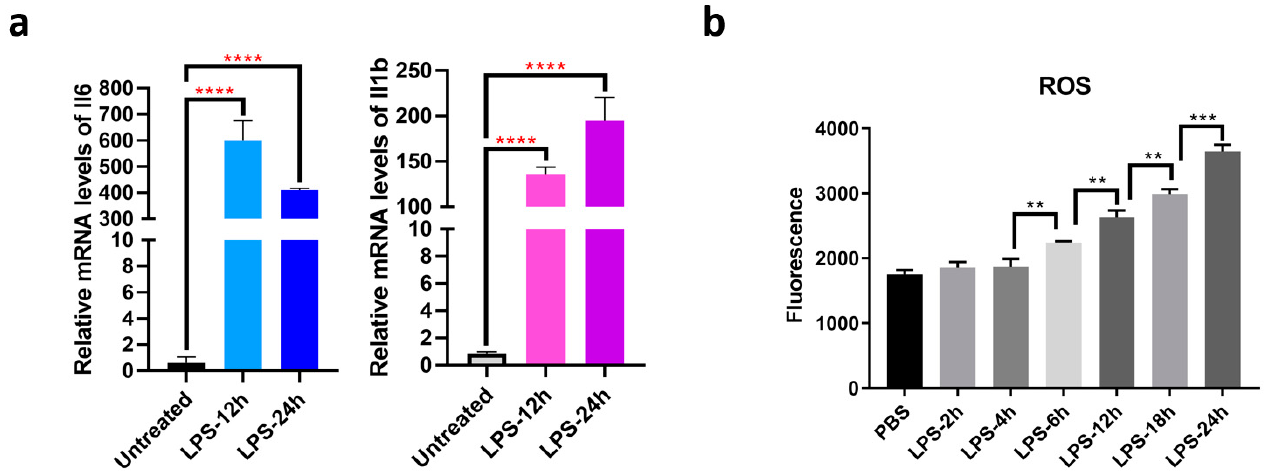
Figure 2. The production of ROS during macrophage activation. ( a ) Il-6 and Il-1 β mRNA levels in RAW264.7 cells treated with LPS; ( b ) Detection of cellular ROS during macrophage activation. **: p < 0.01. ***: p < 0.001. ****: p < 0.0001.